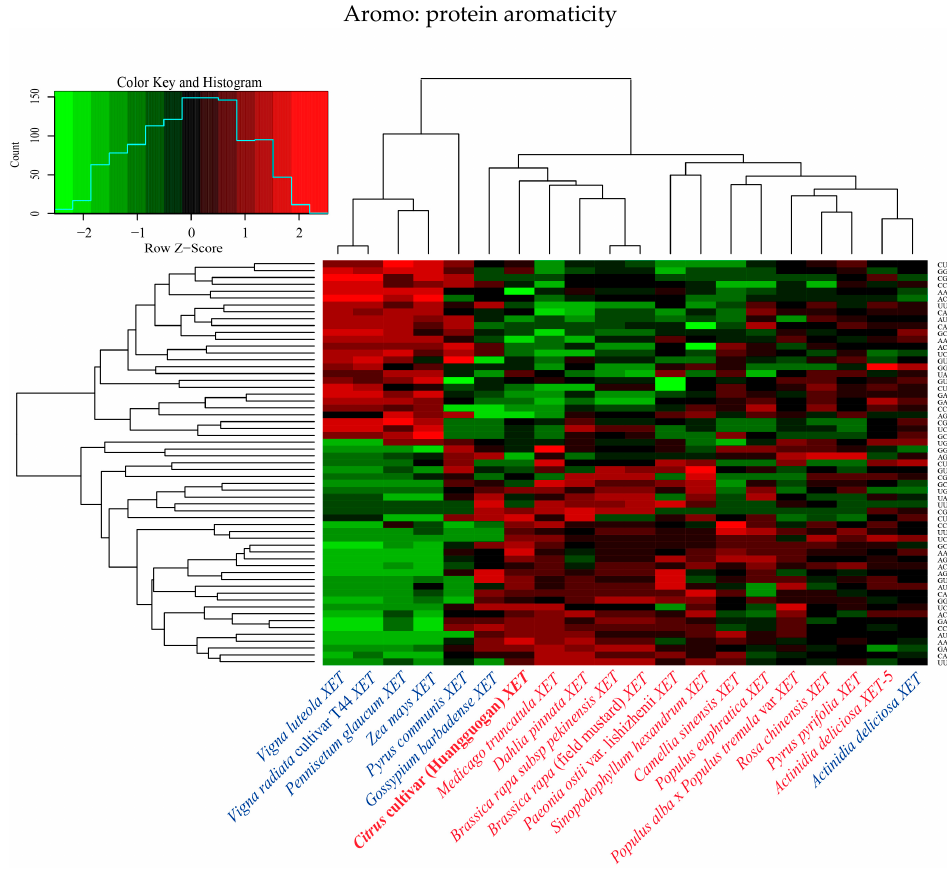
Figure 2. Hierarchical cluster analysis of 59 synonymous codons in 20 XET genes.